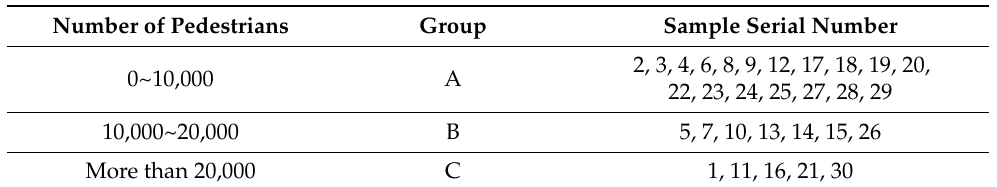
Figure 9. SVM schematic.